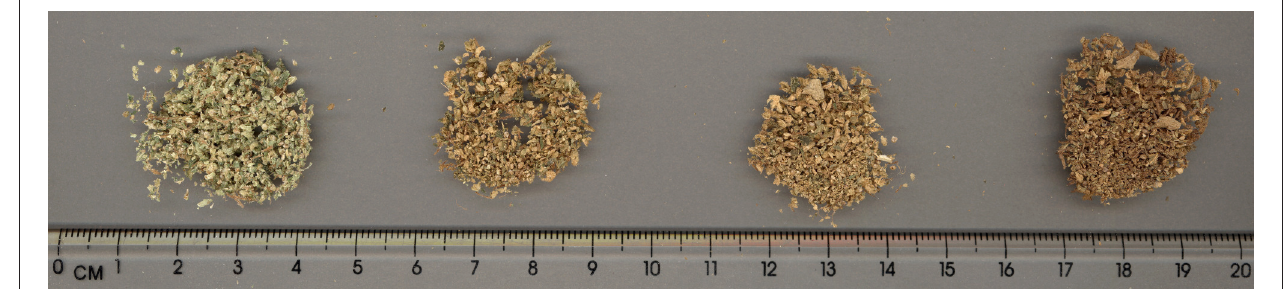
FIGURE 1 | Demonstration of the effects of vaporization of cannabis flower material at different temperatures employing the Volcano Digit Vaporizer (Left to Right): Unheated dried cannabis, Post-vaporization at 175 ◦ C, Post-vaporization at 195 ◦ C, Post-vaporization at 230 ◦ C.